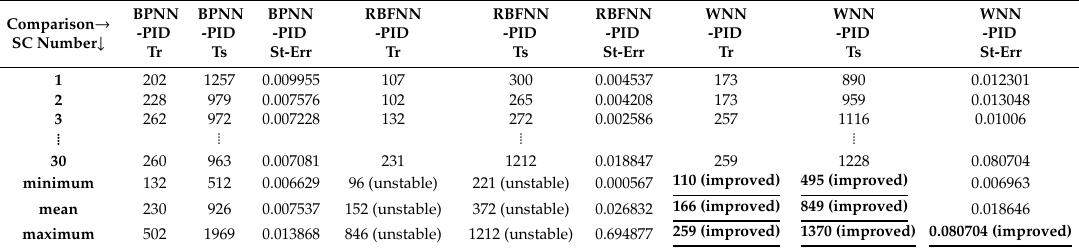
Table 7. Rise time, settling time, steady-state error statistic of 30 simulations.